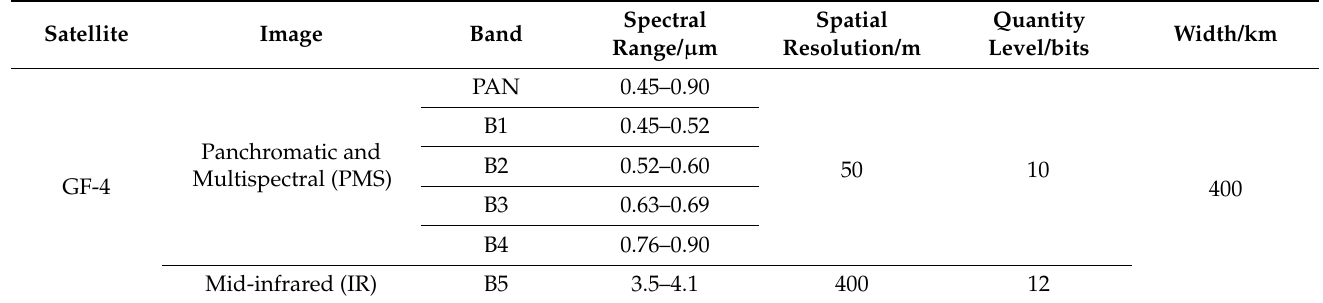
Table 2. Parameters of the GF-4